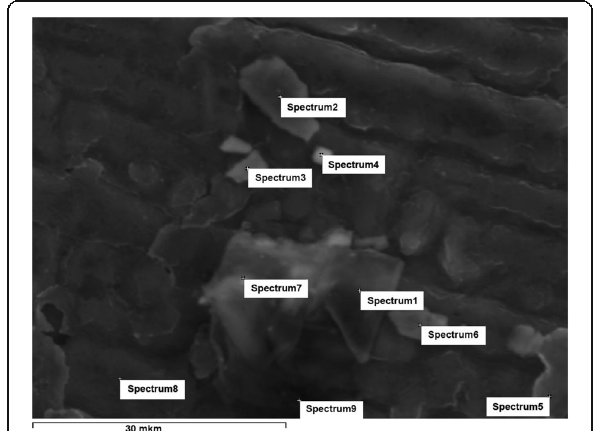
Fig. 8 SEM with elemental analysis. SEM of the composite with 50 phr LiClO 4 surface with the appointment of elemental analysis spectra